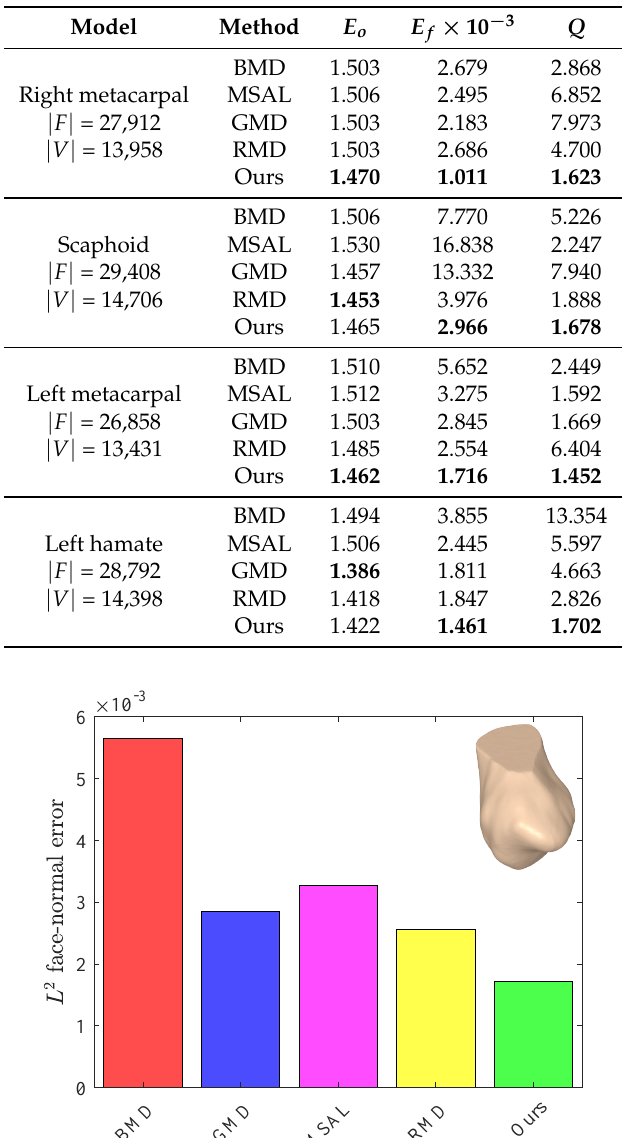
Table 1. Quantitative comparison results using bilateral mesh denoising (BMD), multiscale anisotropic Laplacian (MSAL), guided mesh normal denoising (GMD), robust and high fidelity mesh denoising (RMD), and our approach.